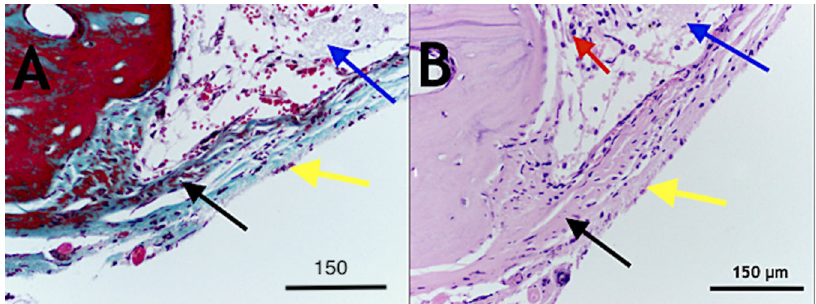
Fig. 6 Photomicrograph showing (Group 1) decalci fi ed histological sections stained with Masson trichrome ( A ) and haematoxylin and eosin (H & E) ( B ). The area of the interface between the remnants of DSM, which became highly cellular with the appearance of osteoblasts